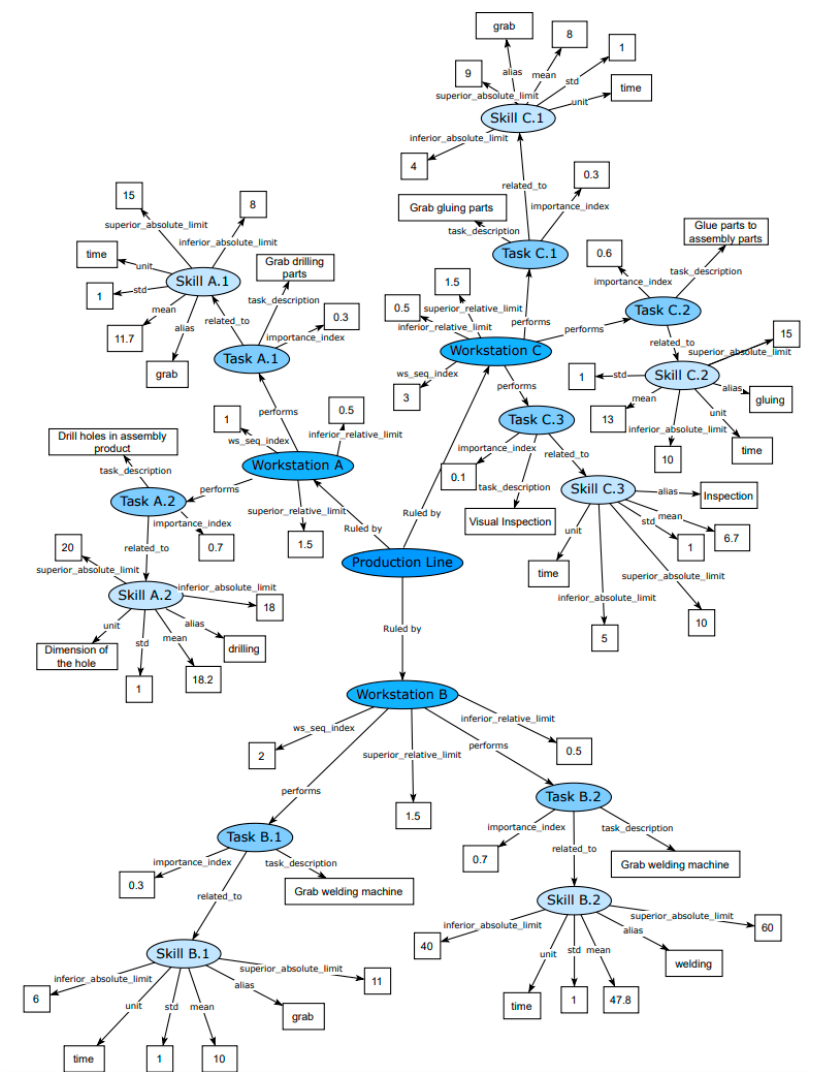
Figure 11. Implementation case description.